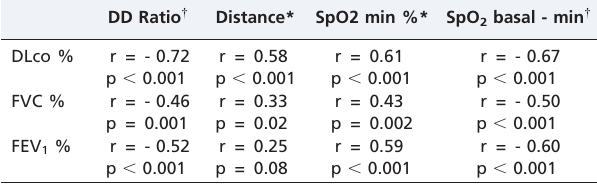
Table 3 - Correlations between six-minute walk test parameters and functional variables in ILD